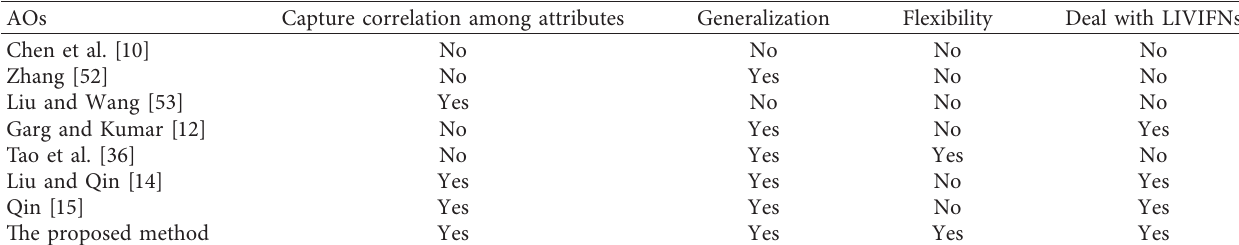
Table 10: The characteristic comparison of different